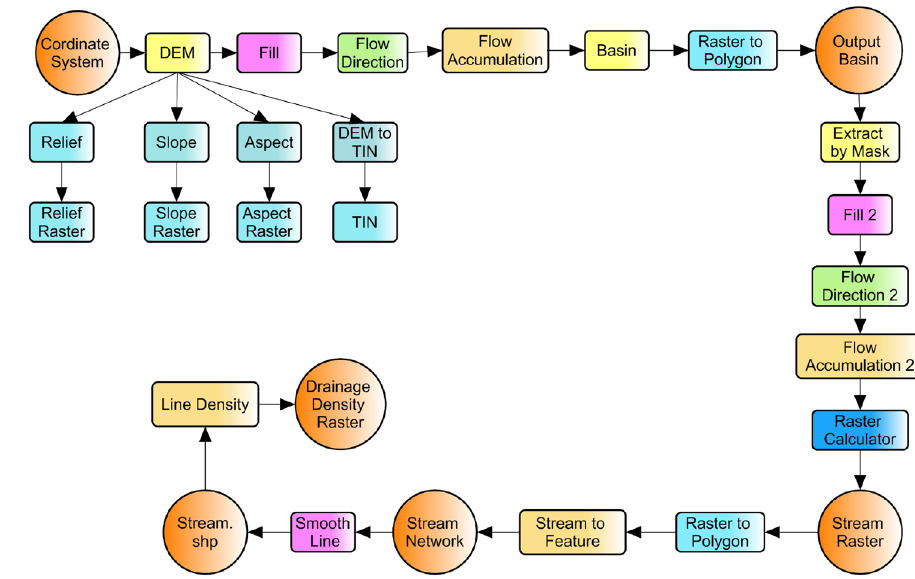
Fig. 3 Flow chart of hydrologi- cal processes of Kosi